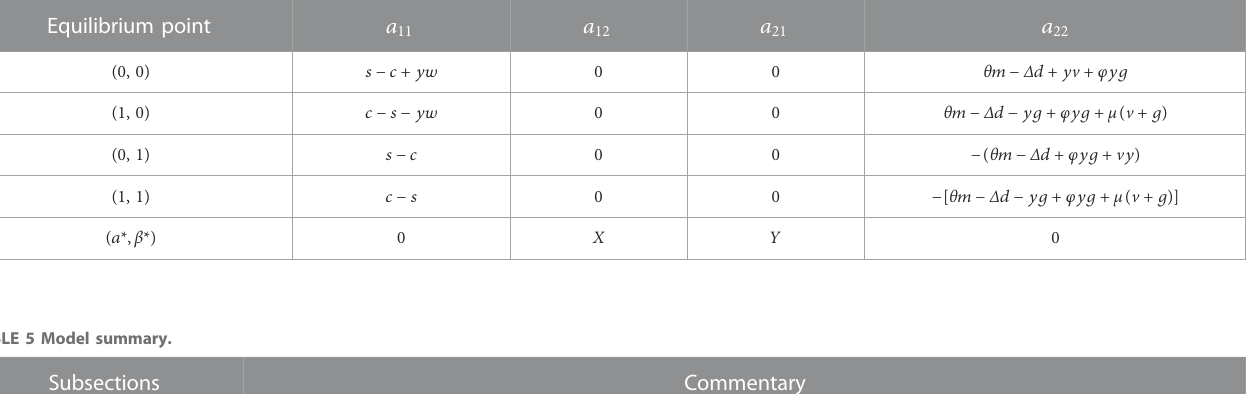
TABLE 4 Values of local equilibrium points. Equilibrium point